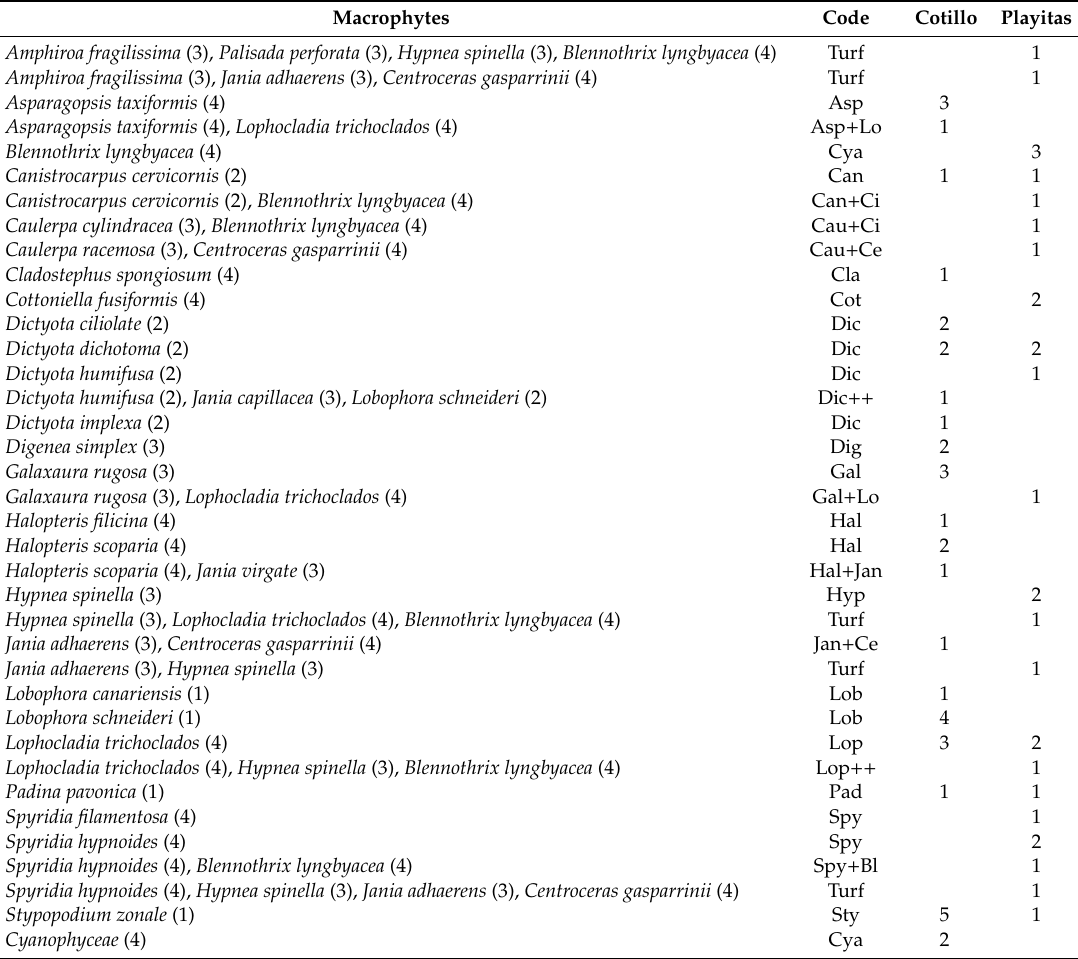
Table 1. Number of samples and species of macrophytes collected in each station. The type of macrophyte according to the thallus structure (see Section 2.3) is indicated in parentheses. The code is used in the figures to indicate the macrophyte